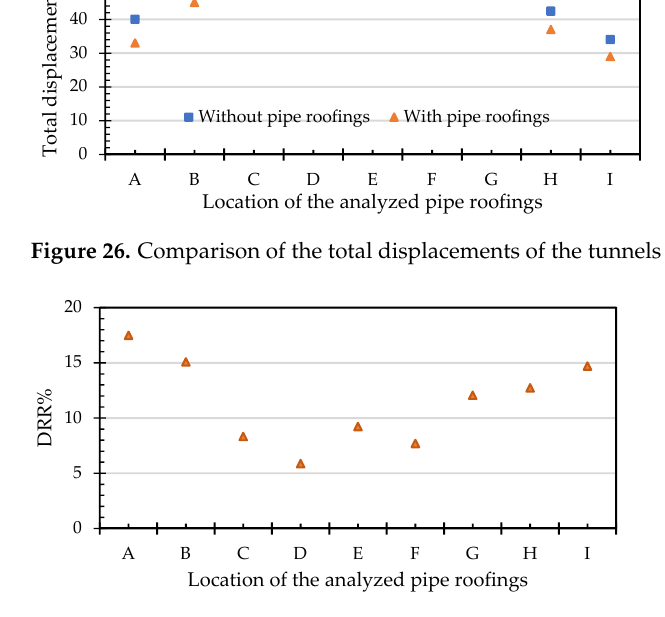
Figure 27. DRR values of various locations with pipe roofings installed.